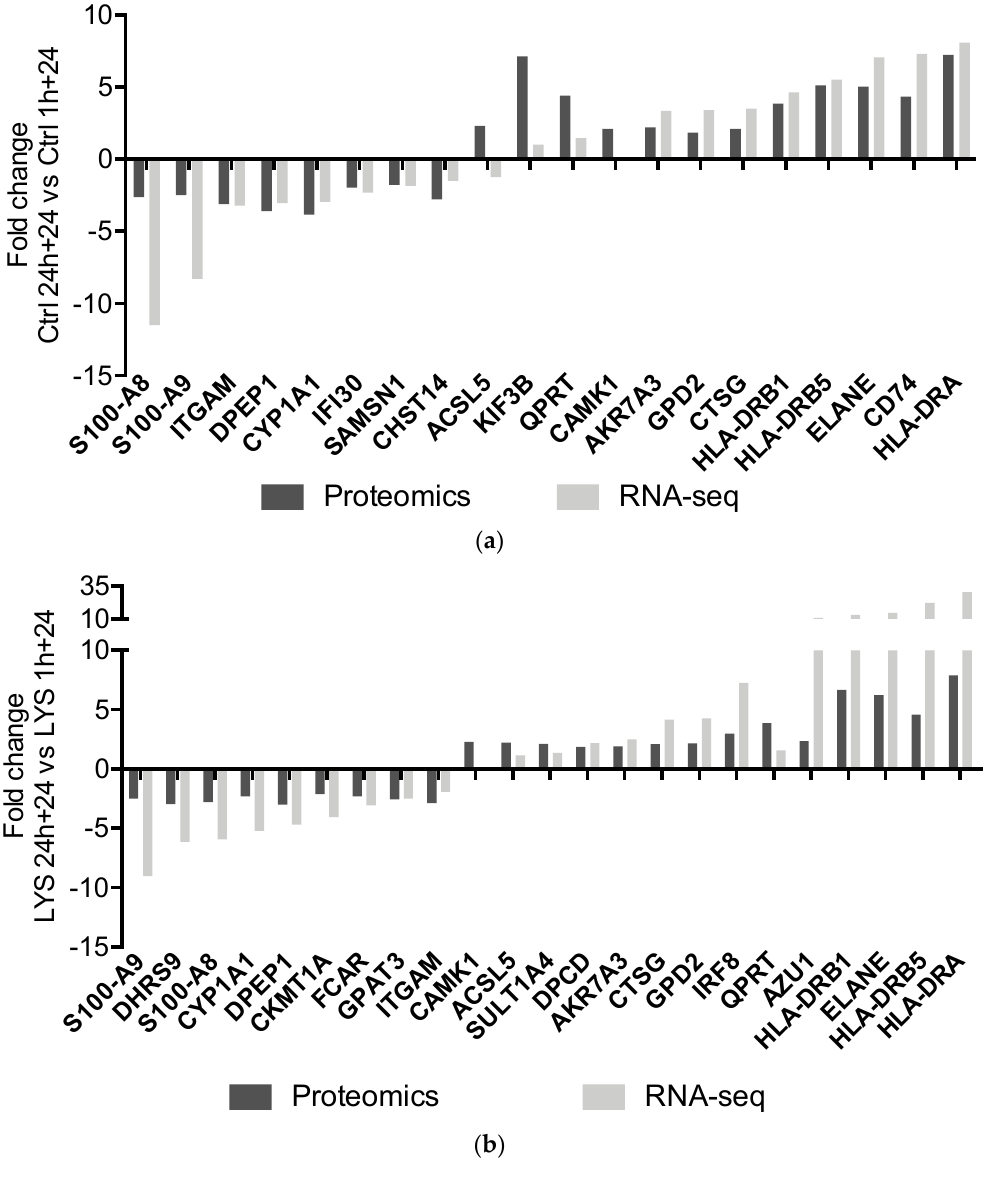
Figure 6. Correlation between the differential expression of proteins and of mRNAs in the control 24 h + 24 versus control 1 h + 24 ( a ) and in LYS 24 h + 24 versus LYS 1 h + 24 ( b ) in U937 cells.